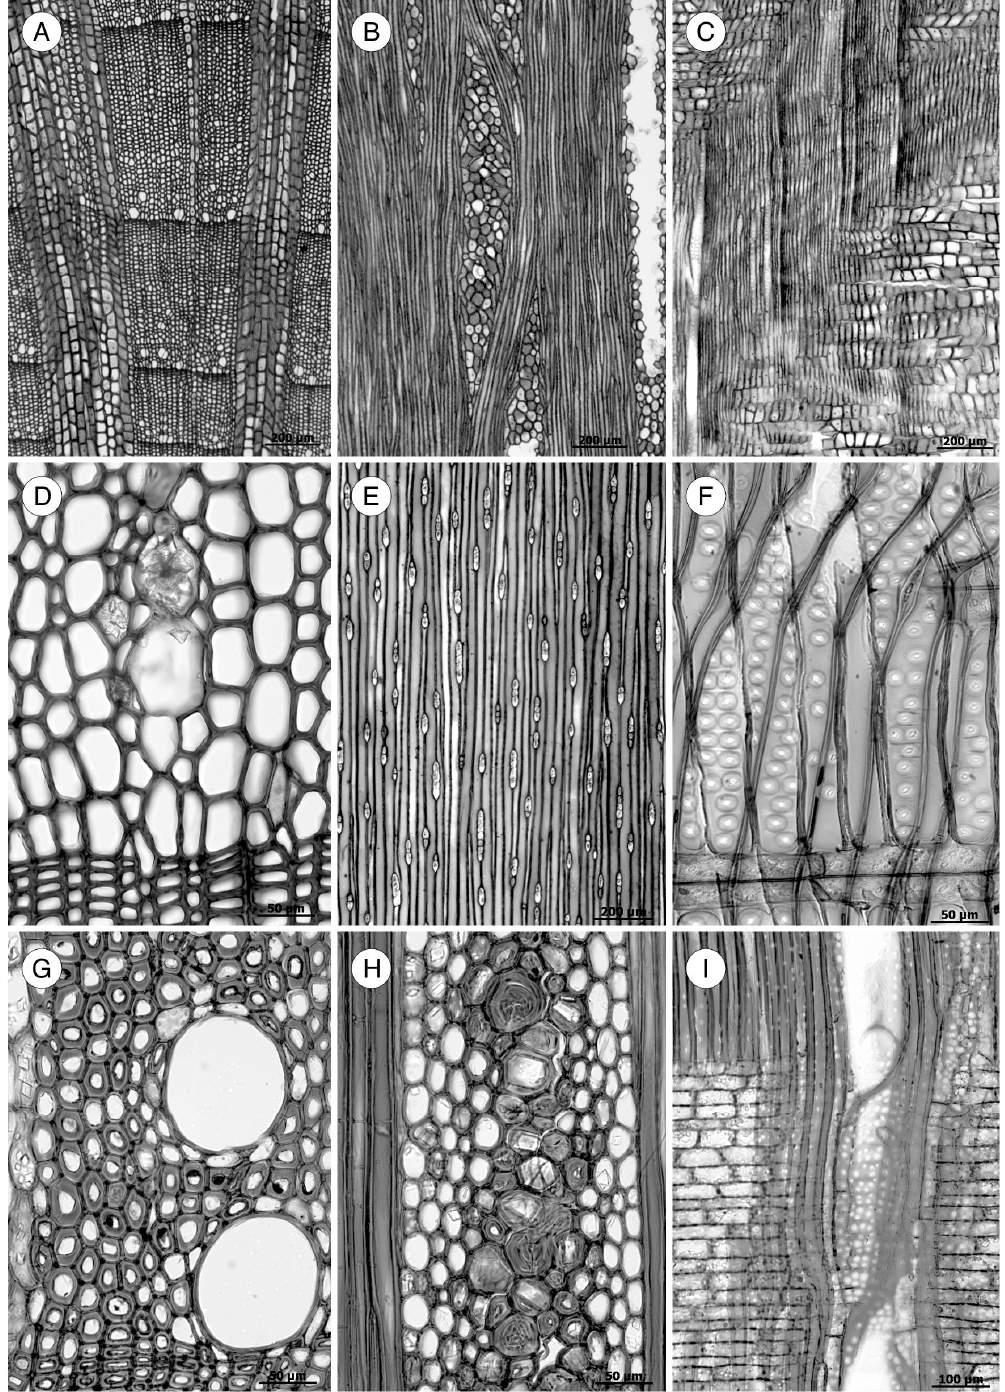
Figure 5. Anatomy of the “wood” of non-coniferous gymnosperms. ( A – C ) Ephedra gerardiana Wall. ex Klotzsch and Garcke; ( D – F ) Ginkgo biloba L.; ( G – I ) Gnetum gnemon L.